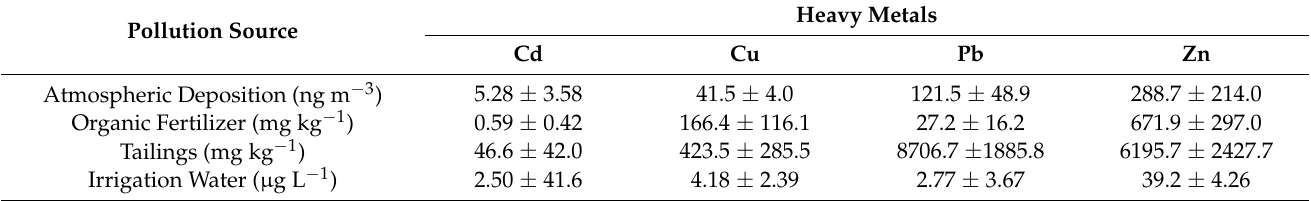
Table 2. Concentrations of heavy metals from different pollution